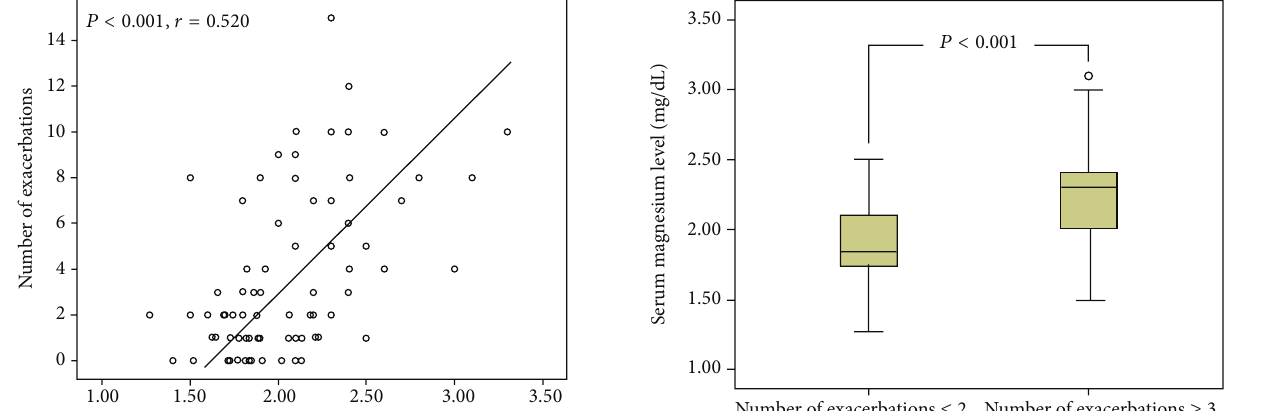
protein ( 𝑃 = 0.006 ) levels were lower in the group with ≥ 3 exacerbations compared to those with ≤ 2, while platelet count ( 𝑃 = 0.028 ) and serum magnesium levels ( 𝑃 < 0.001 ) were higher (Table 3, Figure 3).